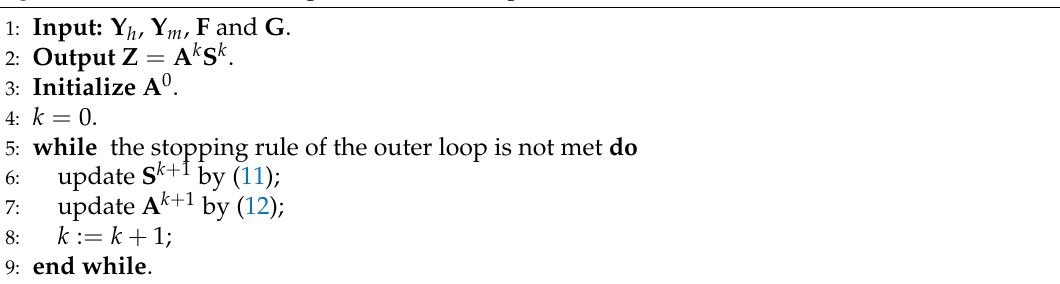
Algorithm 1 JSMV-CNMF algorithm for solving